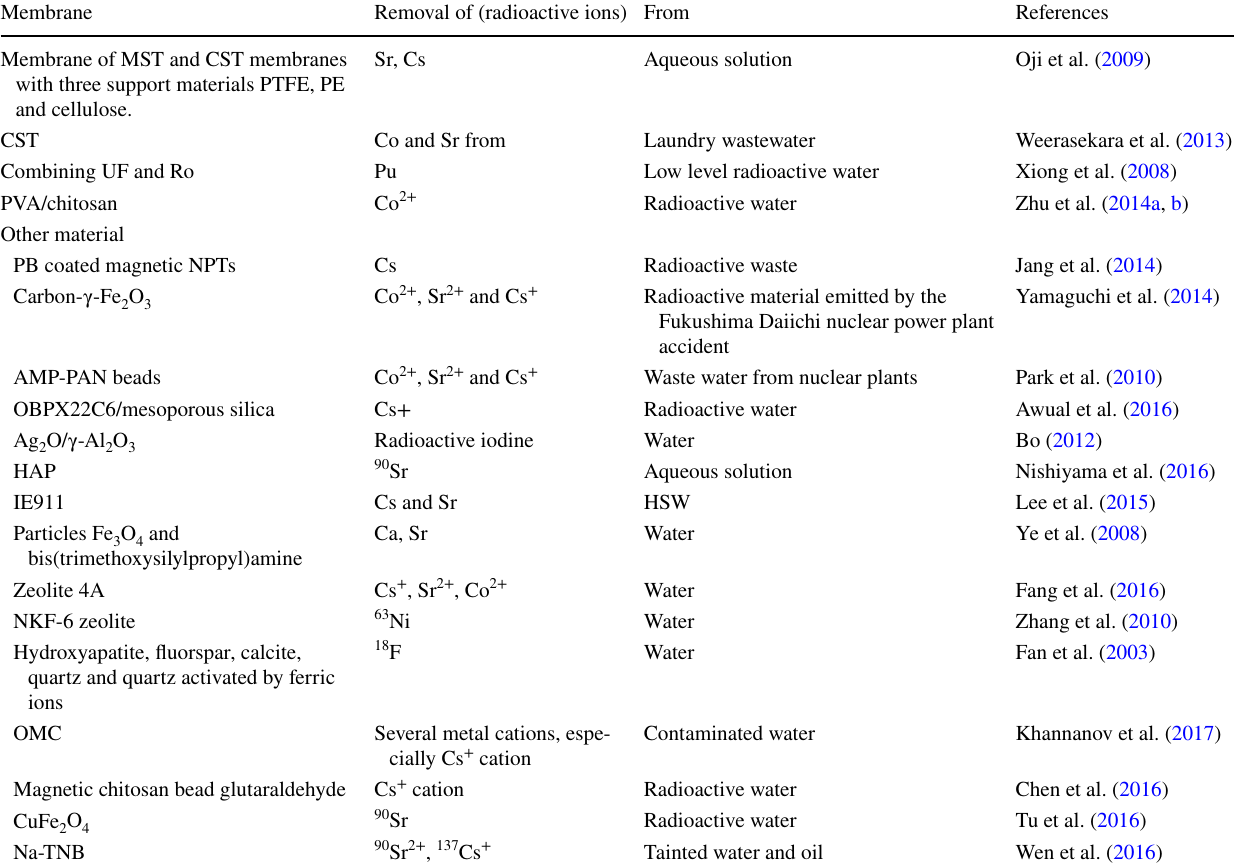
Table 14 Summary of the recent work for the removal of radioactive material from radioactive water/wastewater by absorption using membrane/ other material Membrane Removal of (radioactive ions) From Membrane of MST and CST membranes with three support materials PTFE, PE and